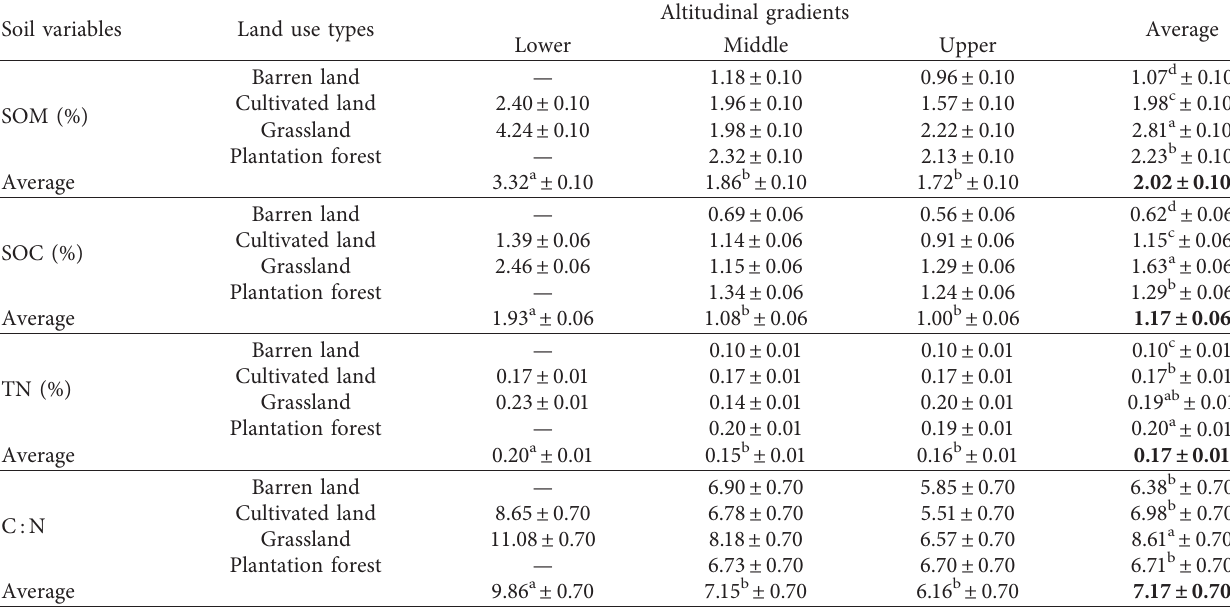
Table 7: Mean values ± SE of soil organic matter (SOM), soil organic carbon (SOC), total nitrogen (TN), and carbon-to-nitrogen ratio (C : N) in different land use types across altitudinal